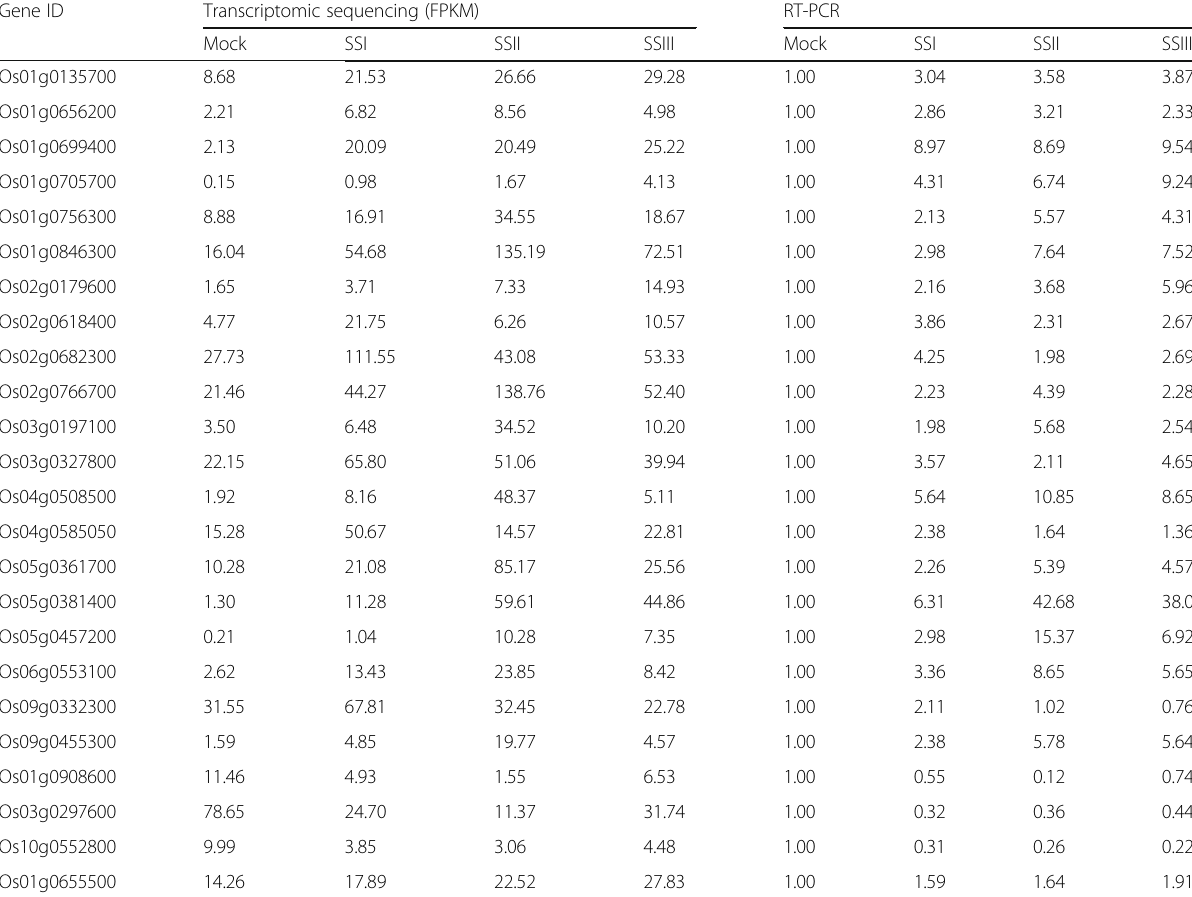
Table 6 The expression value of 24 randomly selected genes in transcriptomic sequencing and RT-PCR Gene